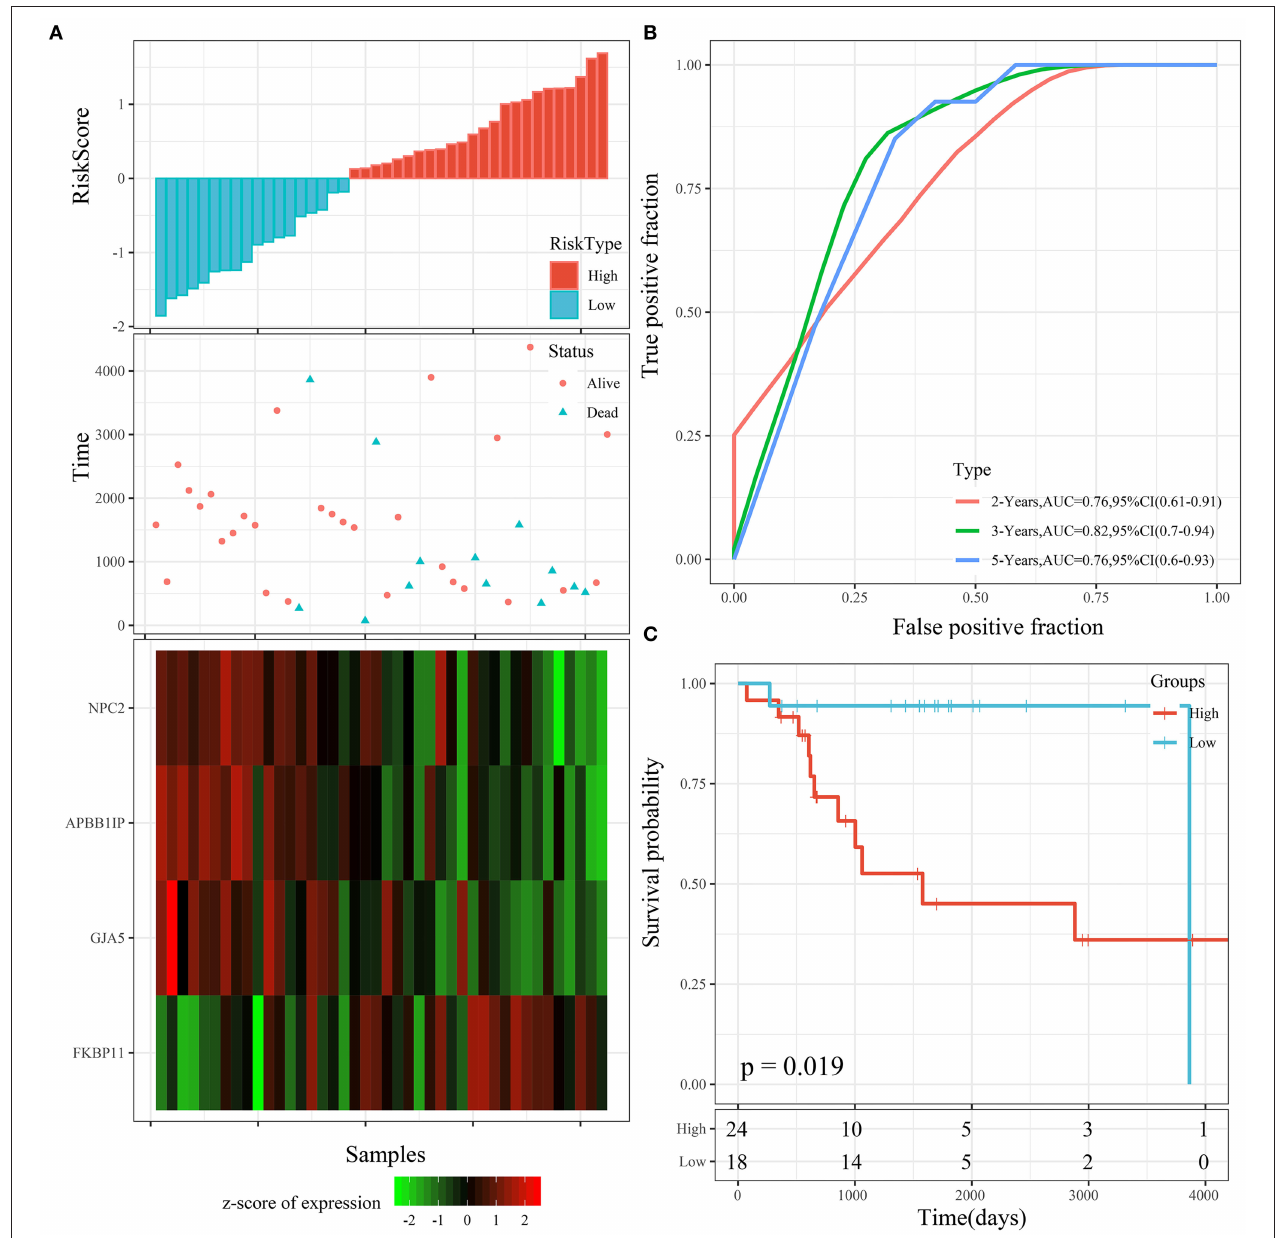
FIGURE 7 | (A) Risk score, survival time, survival status, and 4-gene expression in the TARGET testing cohort. (B) ROC curve and AUC of the 4-gene signature. (C) KM survival curve distribution of the 4-gene signature in the TARGET testing